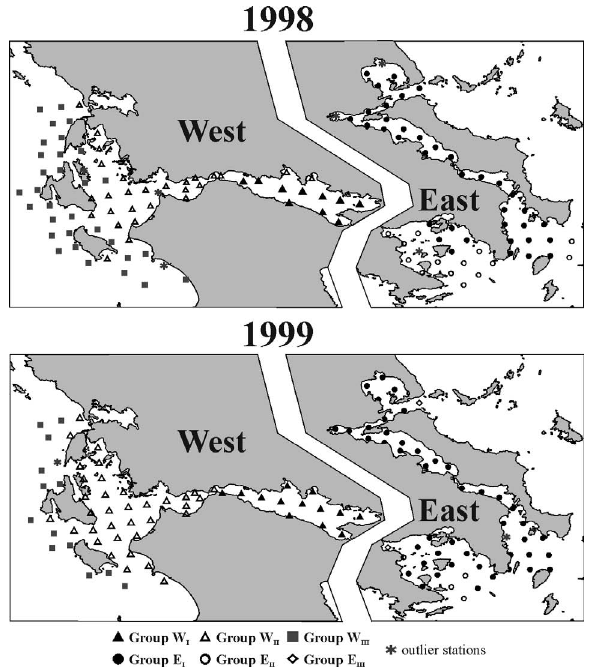
Fig . 7. – Maps showing station groups defined by the cluster